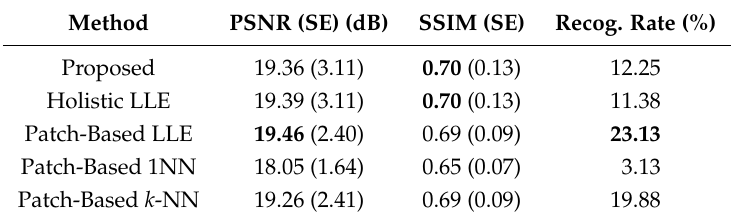
Table 3. Type B: Comparison of the proposed method with the holistic method and various patch-based methods (Number of neighbors: 5, patch size: 9 × 9 pixels). SE represents the standard error.